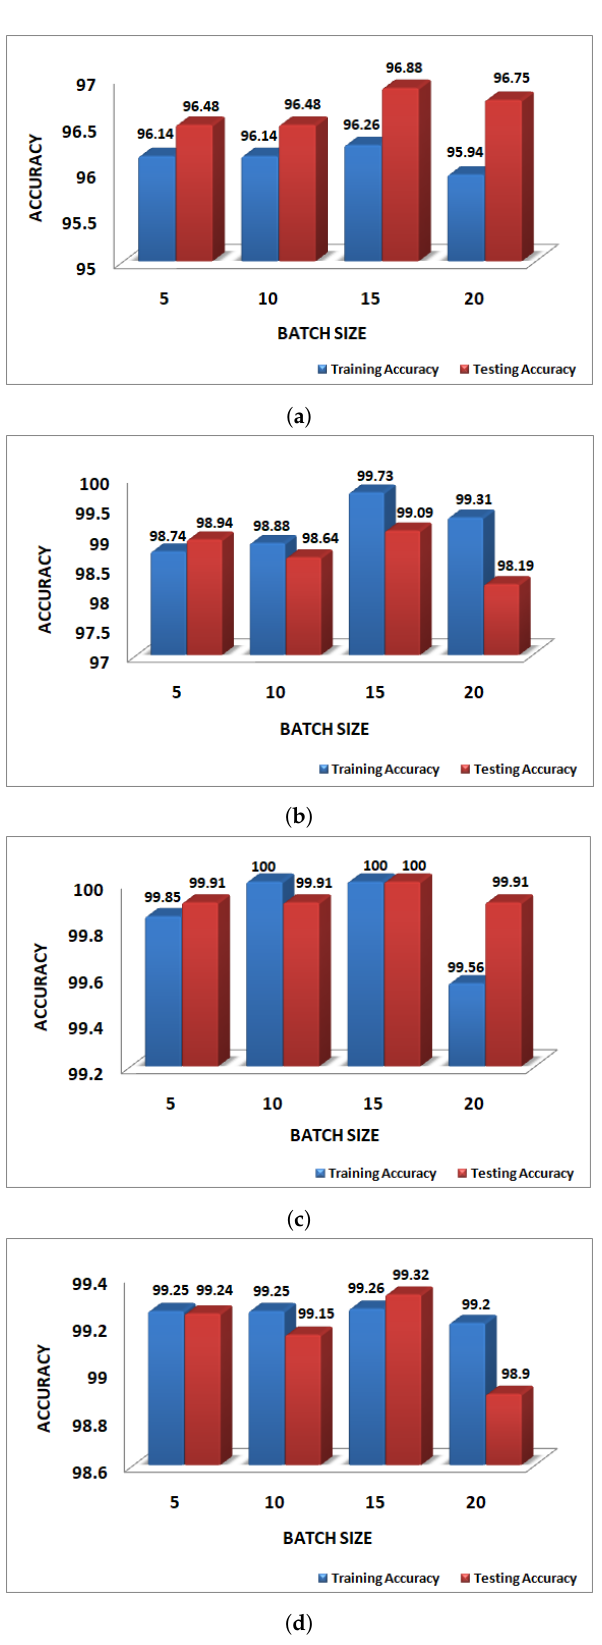
Figure 13. Training and testing performance of DNN model with respect to various batch sizes. ( a ) Noise level: 10 to 50 (Dataset-1). ( b ) THD level: 10 to 50 (Dataset-2). ( c ) THD level: 50, noise level: 10 to 40 (Dataset-3). ( d ) Noise level: 5 to 20